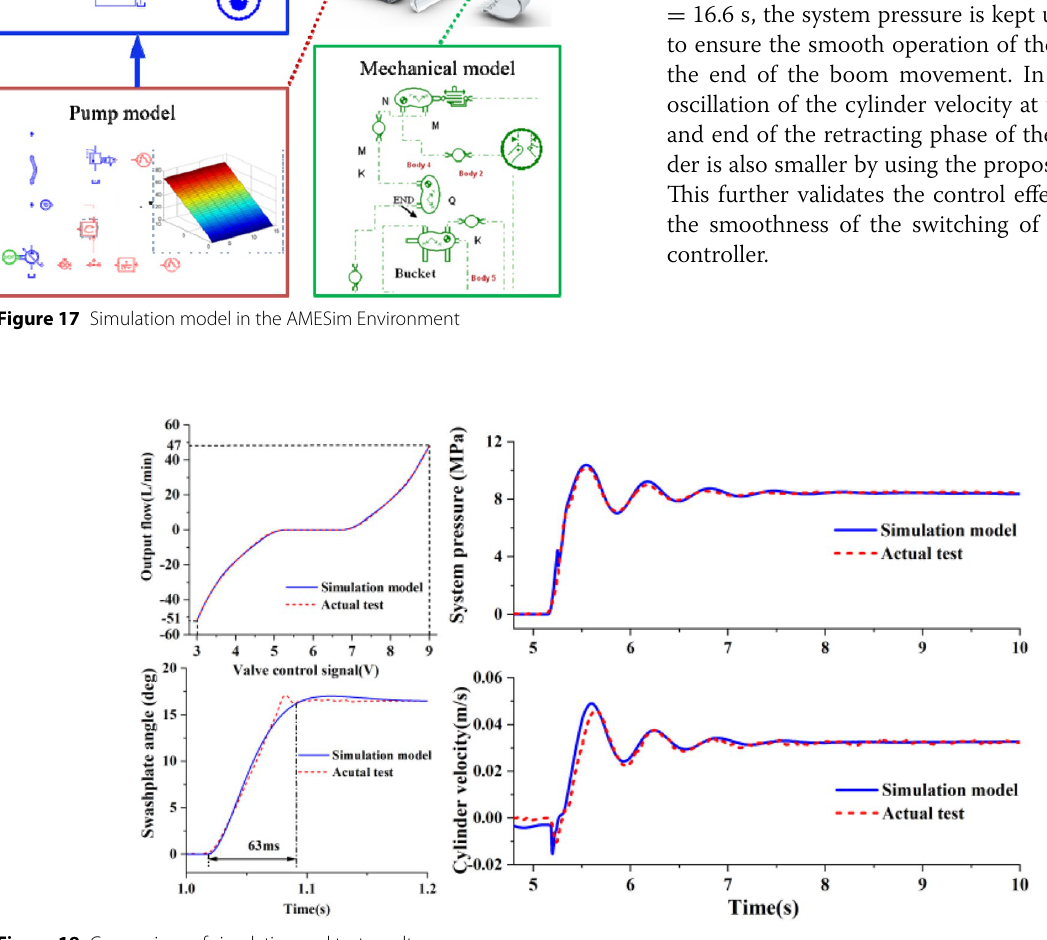
Figure 18 Comparison of simulation and test